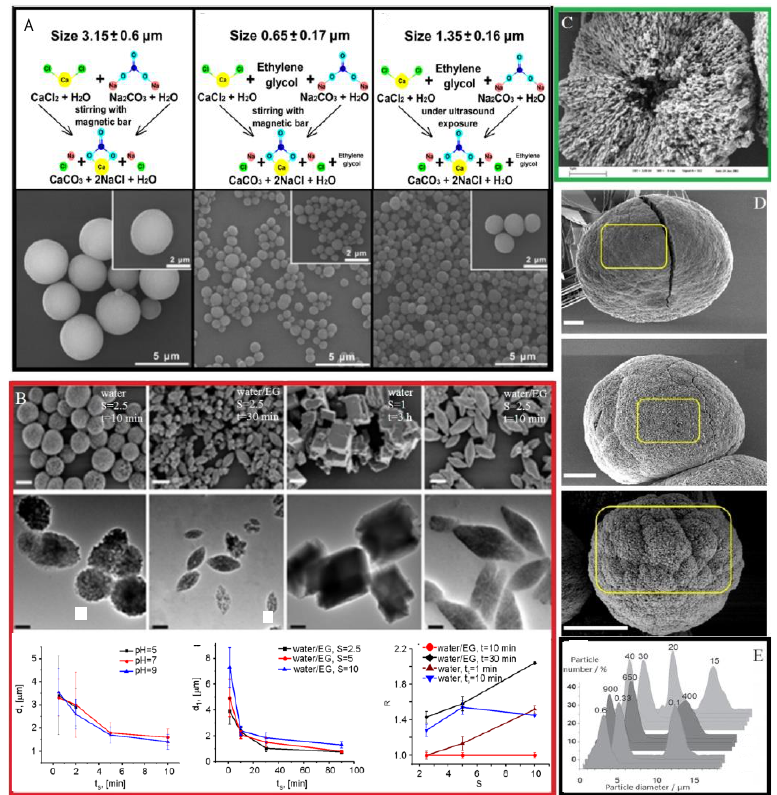
Figure 5. ( A ) Schematic presentation of the three types of synthesis with varied parameters as stirring time, the presence/absence of ethylene glycol, the salt ratio S, and the pH of the solutions and scanning electron microscopy (SEM) images for the obtained vaterite particles with size diameters of 3.15, 0.65, and 1.35 µ m vaterite. Reproduced with permission from [122]. Frontiers Media S.A., 2018; ( B ) SEM images of the CaCO 3 particles synthesized with varying stirring time and presence/absence of ethylene glycol and at pH values of 5, 7, 9 and plots depicted the dependence of particle size from the stirring time. Reproduced with permission from [96]. Springer, 2015; ( C ) SEM images of cross-section of CaCO 3 microparticle. Reproduced with permission [113]. Royal Society of Chemistry, 2004; ( D ) SEM images of CaCO 3 particle grown at different temperature. The pore sizes were found to be 19 ± 5, 28 ± 9, and 44 ± 13 nm for crystals prepared at 7.5, 22, and 45 ◦ C, respectively. Reproduced with permission from [109]. American Chemical Society, 2016; ( E ) CaCO 3 particle size distribution as a function of preparation conditions (salt concentration ( c ), speed ( v ) and time ( t ) of salt stirring). Parameter variations are on the top of the curves. Orange—salt concentration varied ( v = 650 rpm, t = 30 s); violet—stirring speed is varied ( c = 0.33 M, t = 30 s); green—stirring time is varied ( c = 0.33 M, v = 650 rpm). Reproduced with permission from [123]. Wiley Publishing groups,